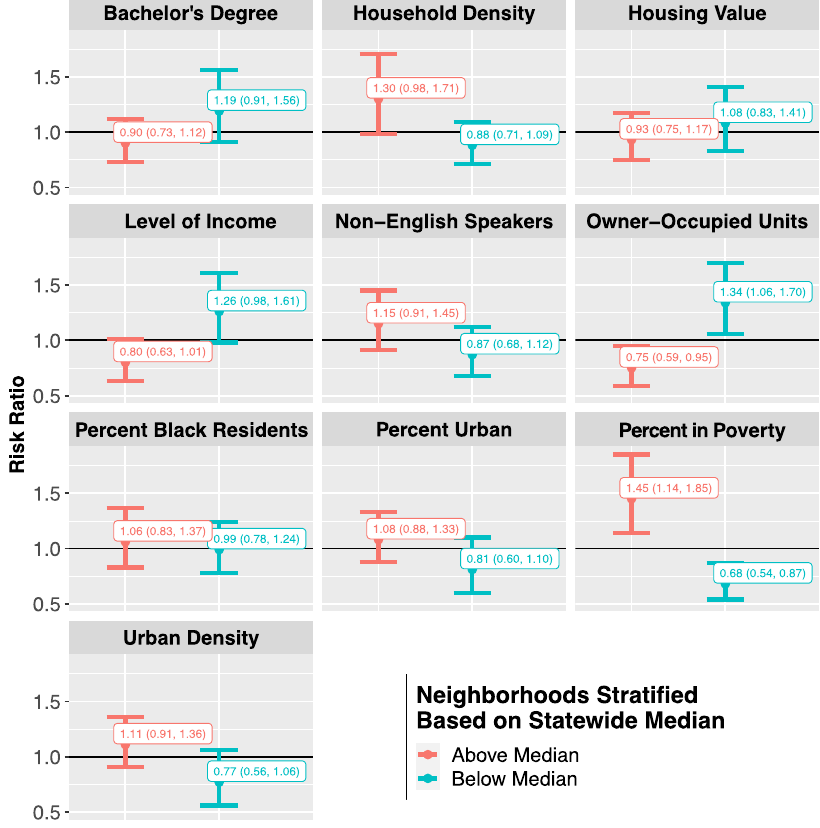
Fig. 4 | Cumulative association between tropical cyclone exposure and CVD hospitalization risk in Florida ZCTAs ( n =796) from 1999 to 2016, by lag (from 2 days before to 7 days after a storm day), strati fi ed by neighborhood-level